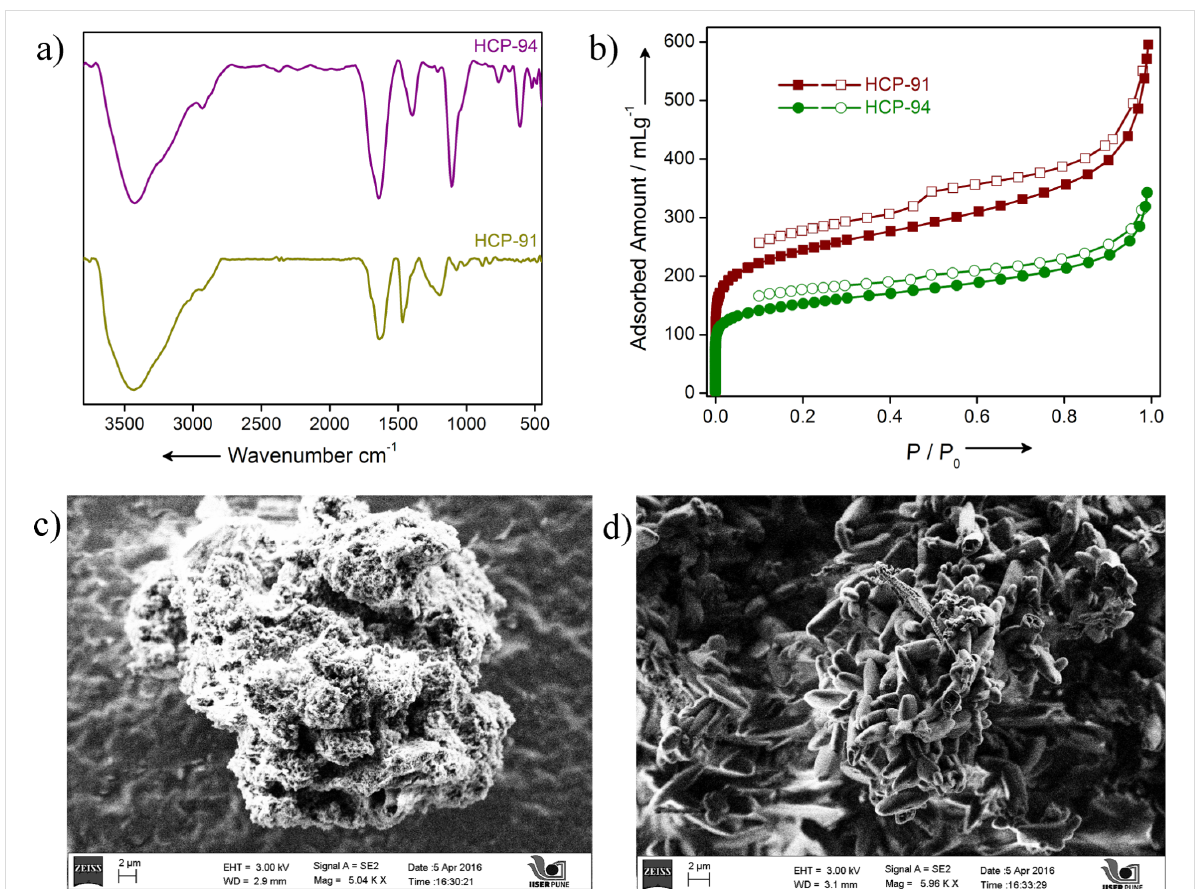
Figure 2: a) Infra-red spectra of HCP-91 (dark yellow) and HCP-94 (purple); b) N 2 adsorption isotherms for HCP-91 (wine red) and HCP-94 (green) at 77 K; c) SEM image of HCP-91 and d) SEM image of HCP-94.